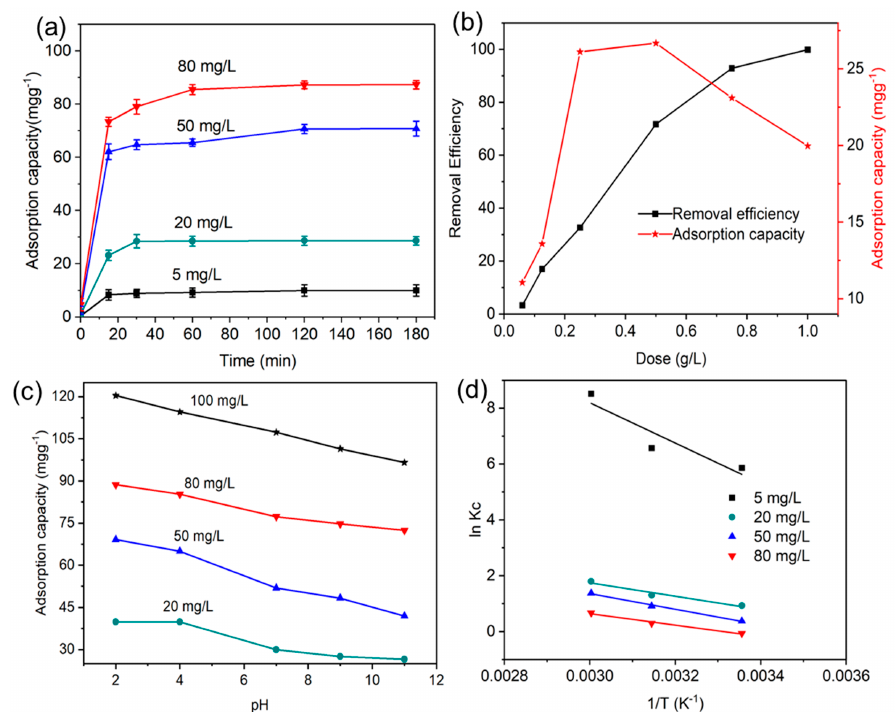
Figure 4. ( a ) Adsorption capacity versus contact time for various initial MO concentrations at T = 298 K; ( b ) effect of increasing dose of adsorbent on removal efficiency and adsorption capacity; ( c ) Effect of pH on the adsorption capacity of LIG/TiO 2 ; ( d ) plots of LnK c versus 1/T for the adsorption of MO on LIG/TiO 2 at different dye